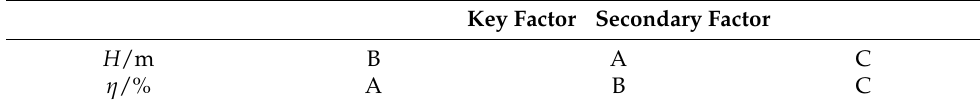
Table 11. The order of influence of the factors on pump performance at 1.4 Q des